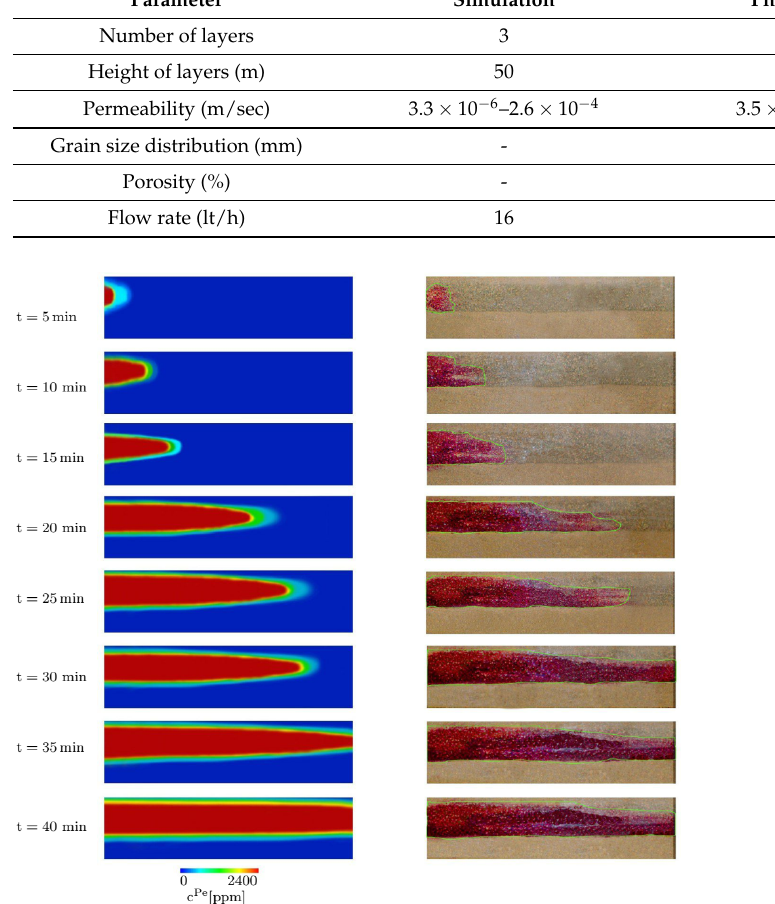
Figure 6. The comparison between the simulation ( left ) and experiment ( right ) for a three-layer physical sandbox. The color bar shows the permanganate